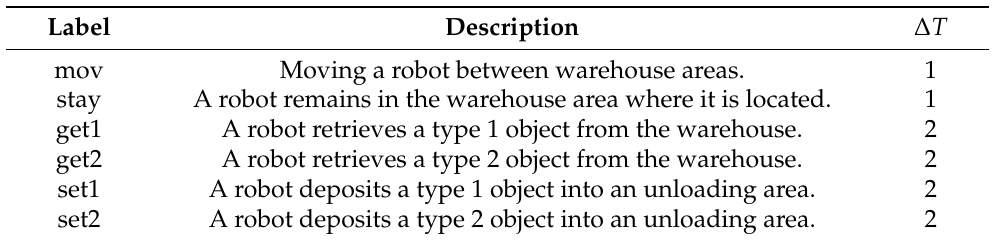
Table 20. System reaction rules for the example of checking whether non-functional requirements are satisfied. A value in the third column is the amount of time required to execute a rule.